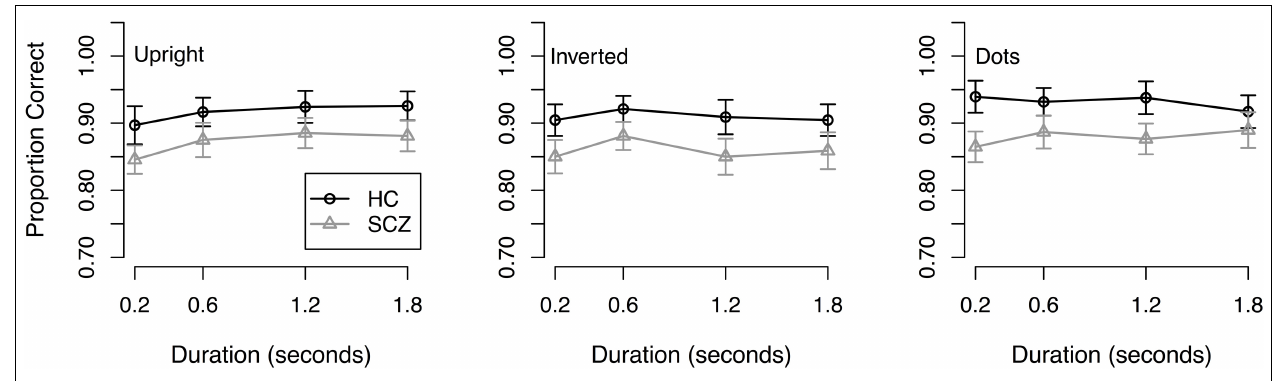
FIGURE 2 | Response accuracy from Experiment 2. Both groups showed better performance in the dots condition compared to upright and inverted point-light walkers. Both groups also showed better performance in the upright condition compared to the inverted condition. No interactions were found.